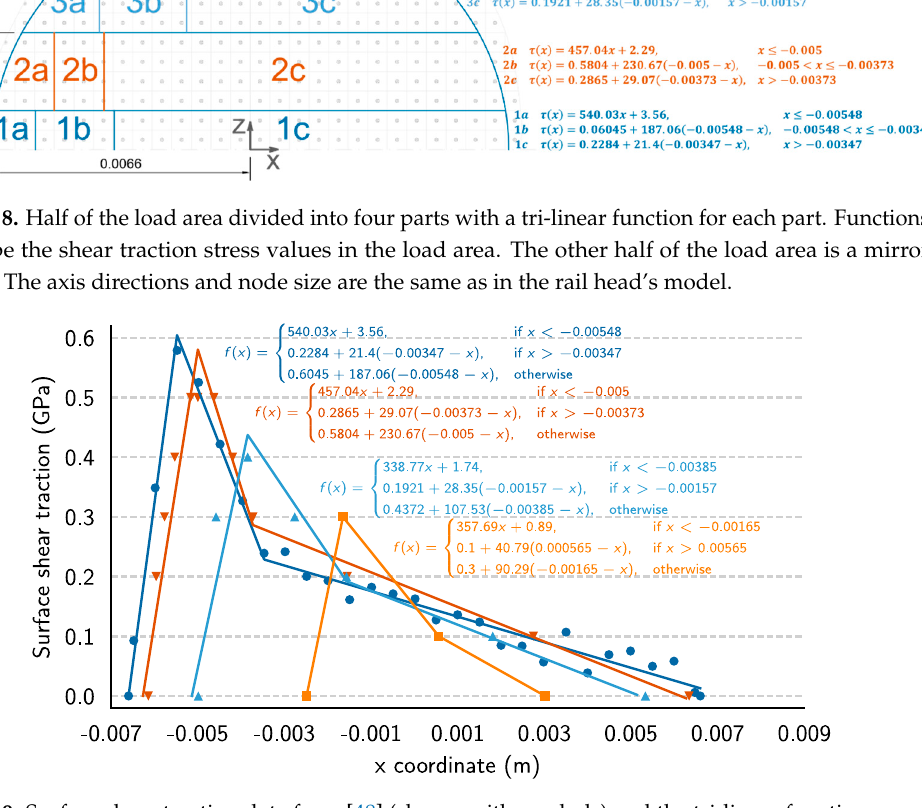
Figure 9. Surface shear traction data from [48] (shown with symbols) and the tri-linear functions used to describe the shear traction values in the load area.